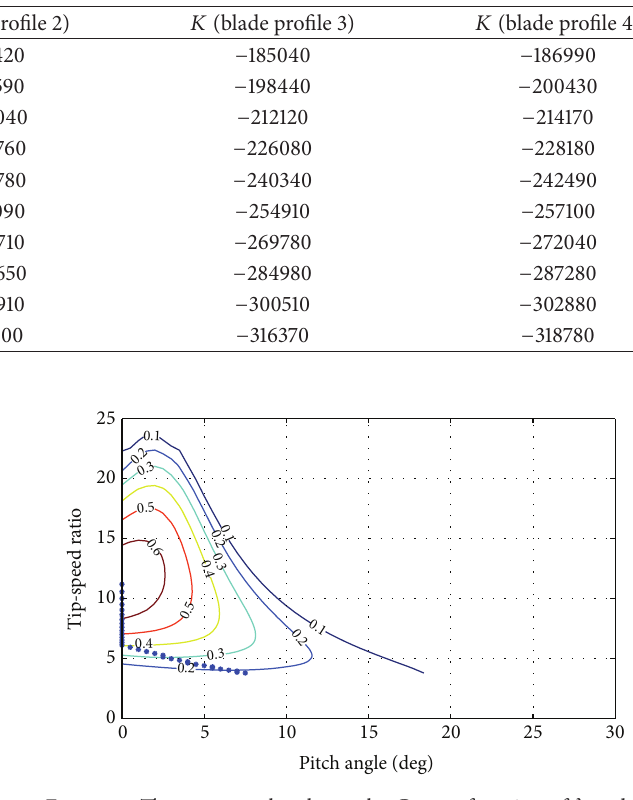
Figure 5: The contour plot shows the 𝐶 𝑝 as a function of 𝜆 and 𝛽 and the star indicates the optimal operation for the wind